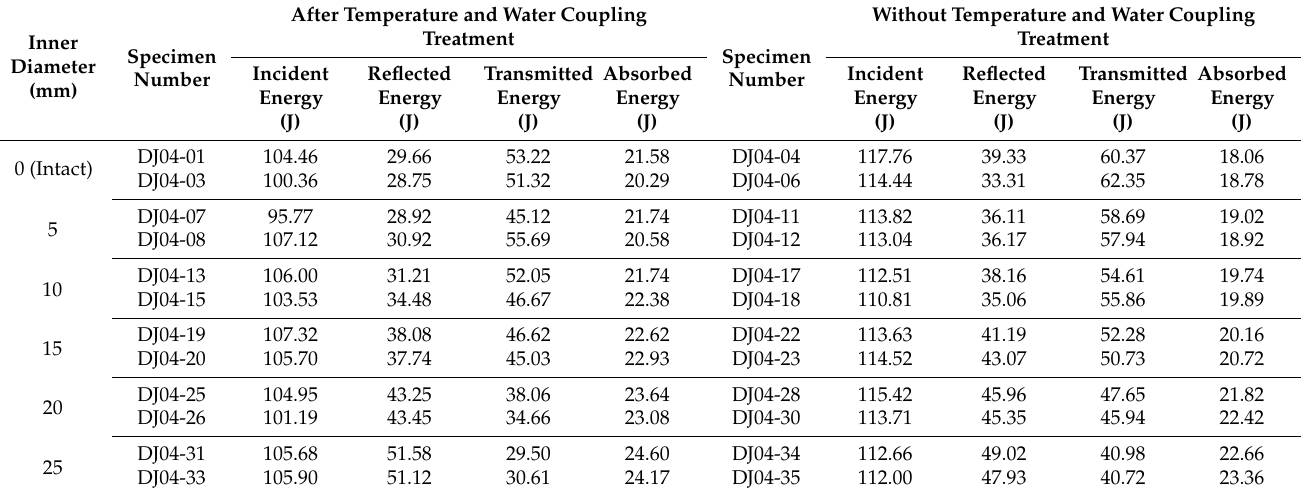
Table 3. Energy data of sandstone specimen.